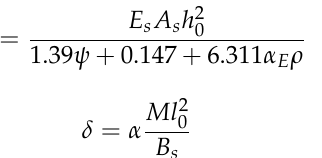
Table 7. Comparison of the experimental and calculation results for crack width of RASCC beams and NC beams.